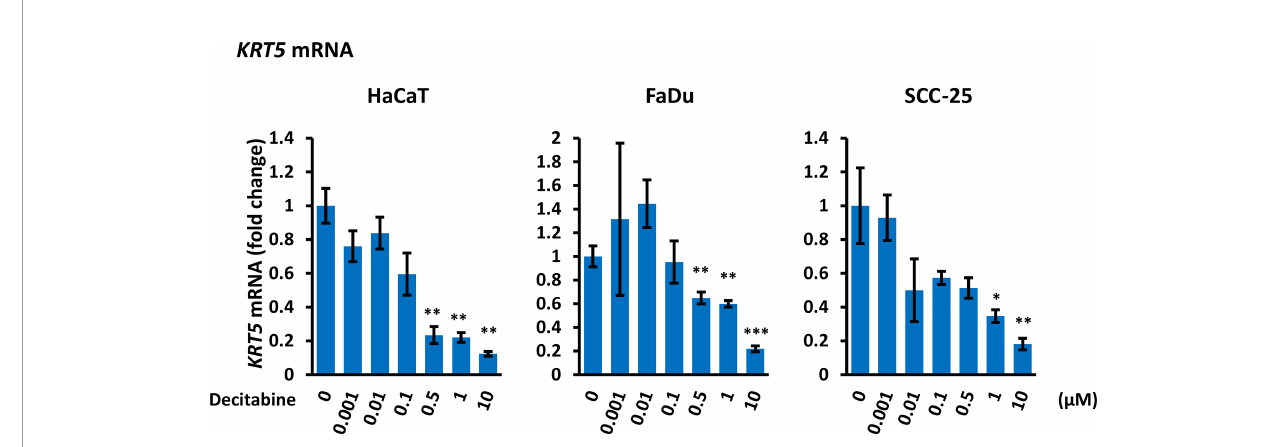
FIGURE 3 | Decitabine decreases KRT5 mRNA. Cells were treated with the indicated concentrations of decitabine for four days and analyzed for KRT5 mRNA by RT-qPCR. Data are shown as fold change ± SEM compared to control cells (0; DMSO only) and are normalized to ACTB mRNA (n = 3 biological replicates with technical triplicates for each concentration in each cell line). *p < 0.05; **p < 0.01; ***p < 0.001 compared to untreated